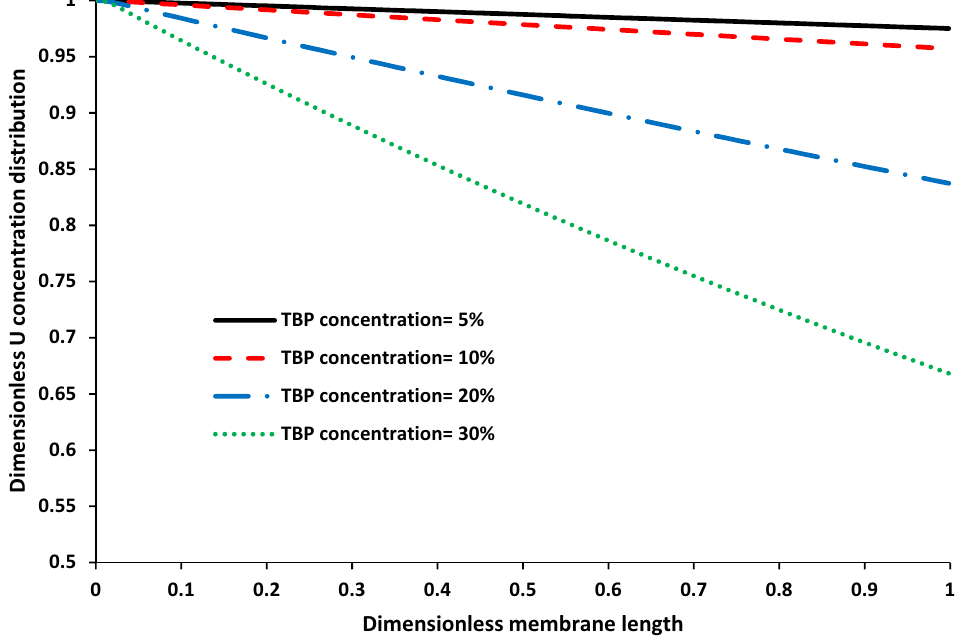
Figure 5. Dimensionless uranium concentration distribution along membrane contactor at different TBP